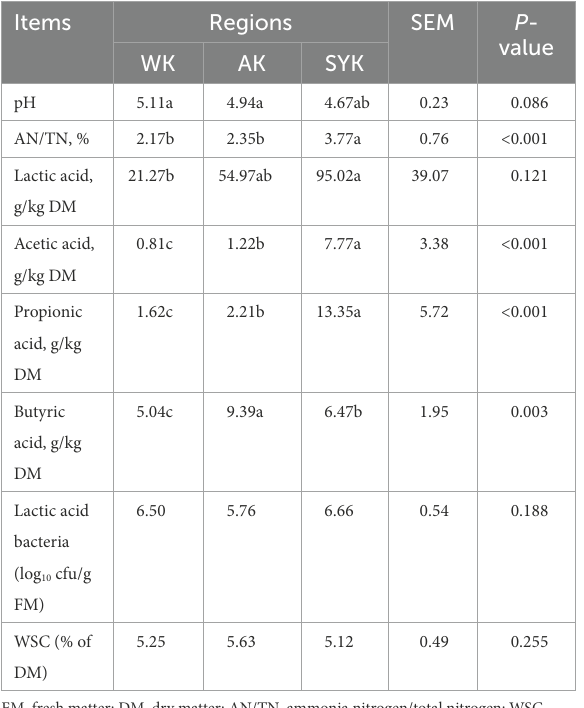
TABLE 3 Fermentation quality of ryegrass silage in different